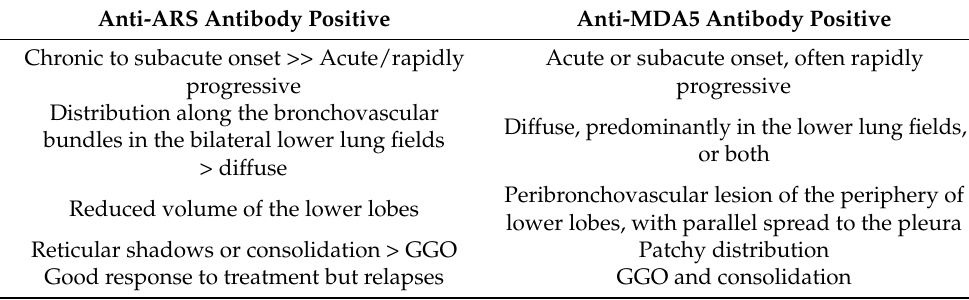
Table 2. Common imaging findings based on the